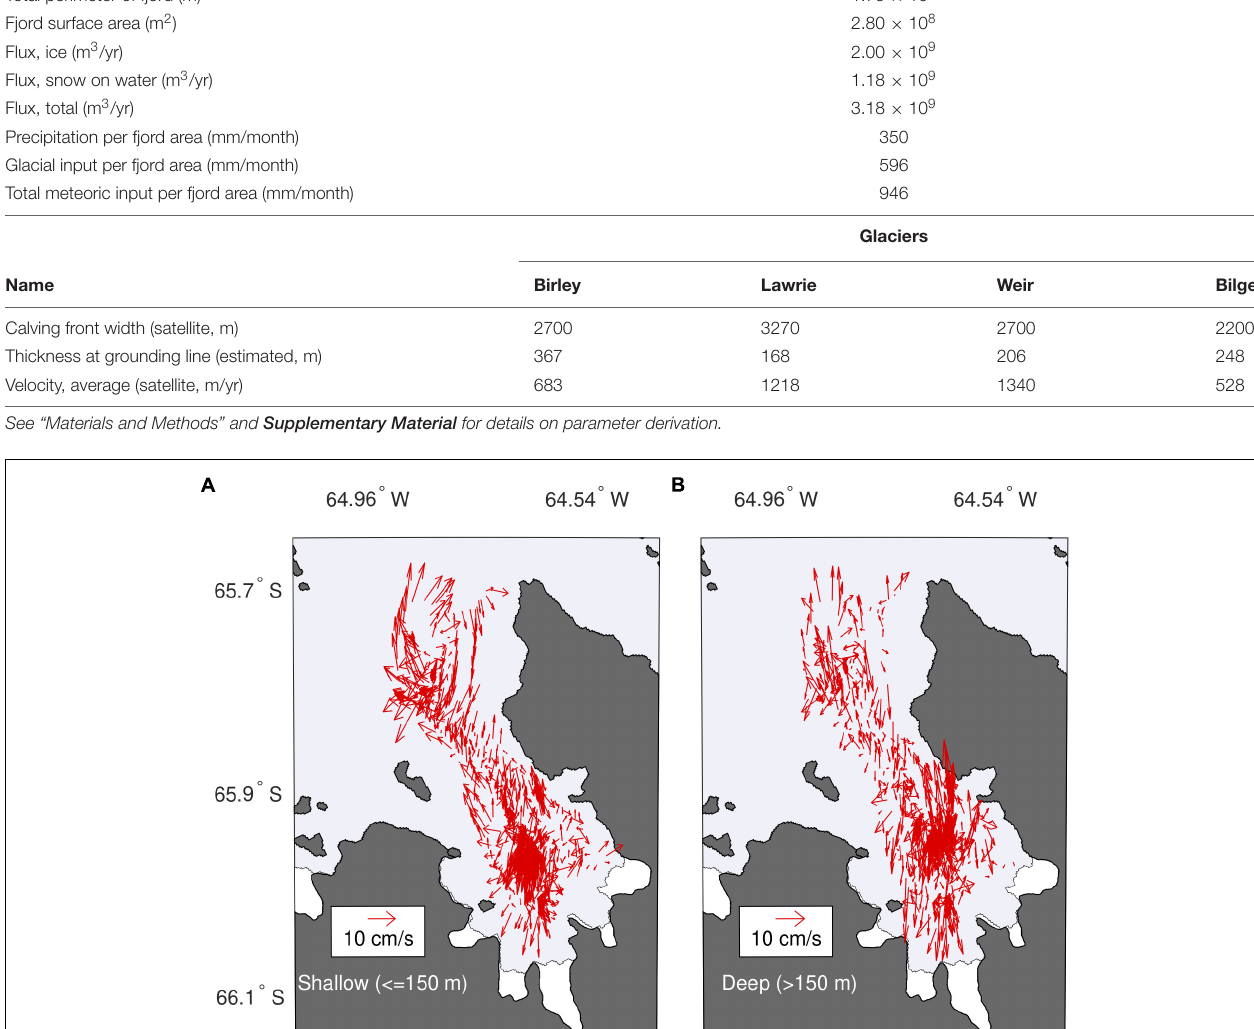
chl-a fluorescence, measured from the seawater intake, show